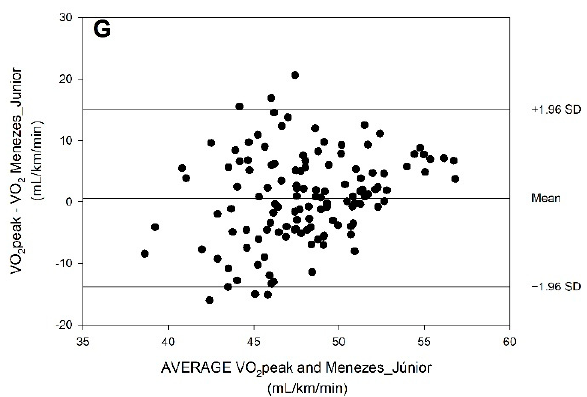
Figure 1. Bland–Altman plots regarding the measured VO2peak values and the predictive equations predicted VO2peak values: ( A ) Leger et al. (1988), Equation #1, with PGA; ( B ) Leger et al. [42], Equation #1, without PGA; ( C ) Barnett et al. [20], Equation #4, with PGA; ( D ) Barnett et al. [20], Equation #4, without PGA; ( E ) Matsuzaka et al. [18], Equation #6, with PGA; ( F ) Menezes-Junior et al. [1], Equation #21, with PGA; ( G ) Menezes-Junior et al. [1], Equation #21, without PGA.